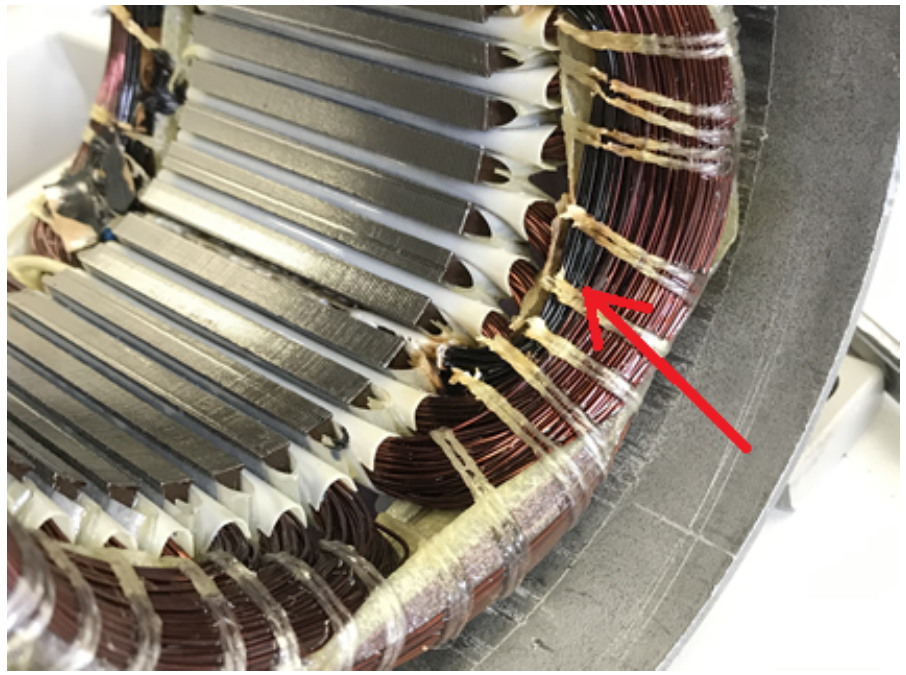
Figure 4. Damage of short circuit in stator winding.